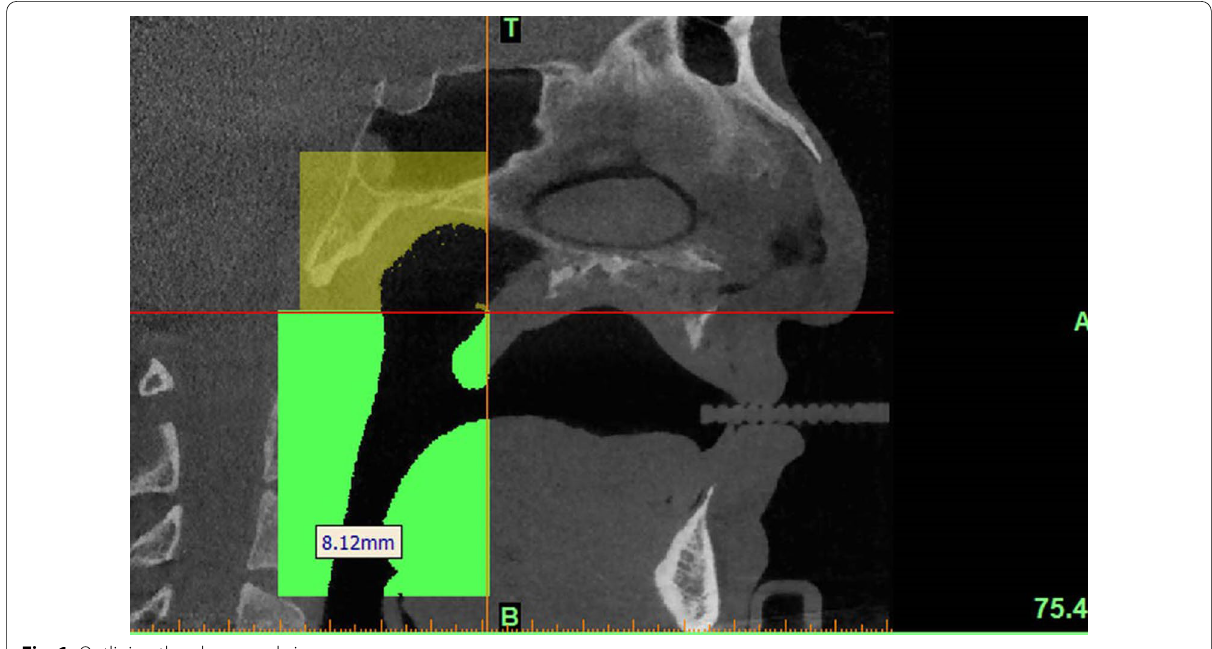
Fig. 1 Outlining the pharyngeal airway